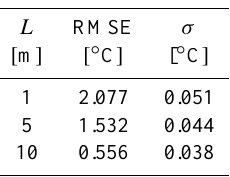
Table 1. Sensitivity analysis of the extended calibration for dif- ferent lengths ( L ) of the calibration sections. RMSE and σ cor- respond to the root mean square error and the standard deviation of the extended-calibrated temperatures in the known-temperature sections.